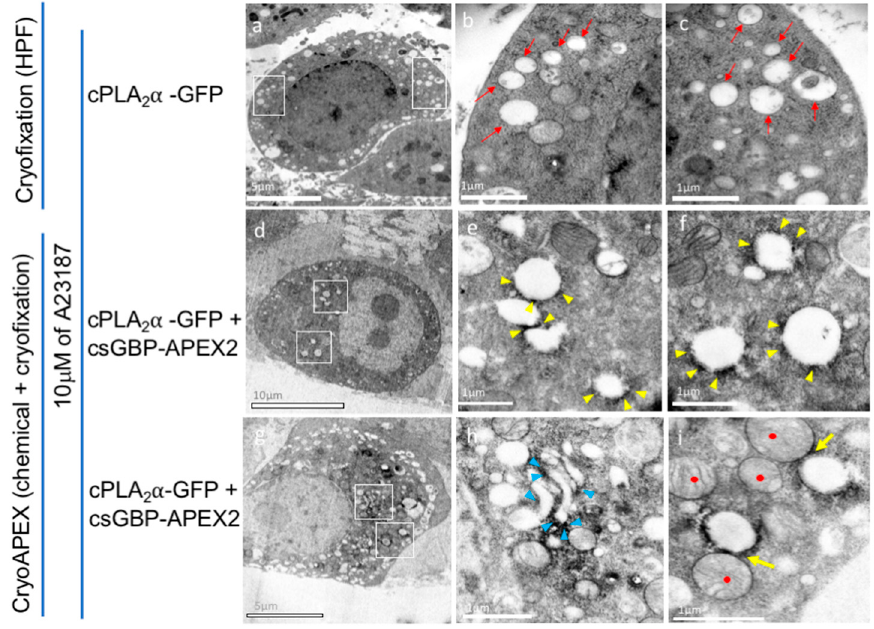
Figure 6. Cells ectopically expressing cPLA 2 α in the presence of calcium ionophore exhibit extensive vesicular structures with detectable presence of cPLA 2 α on vesicles and Golgi. ( a ) Cryogenically fixed (HPF) HeLa cells expressing cPLA 2 α when exposed to 10 μ M A23187 results in the accumulation of vesicular structures in the cytoplasm. At higher magnification of the areas ( a , white boxes) these vesicles show lack of density within and exhibit size heterogeneity (red arrows, b and c ). ( d ) Indirect cryoAPEX using an anti-GFP nanobody (APEX2-csGBP) tagged with APEX2 protein detected density corresponding to cPLA 2 α -GFP in the cytoplasm at lower magnification. ( e ) At higher magnifications the APEX2 specific osmium staining was apparent around these vesicles ( e and f , yellow arrowheads) indicating the concentration of cPLA 2 α in consonance with confocal imaging presented earlier. Stacked membrane bound structure resembling that of Golgi complex were also stained with apex2 specific osmium, ( g and h , blue arrowhead). These stained vesicles were often found to be closely associated with mitochondria (i, yellow arrow; red dots = mitochondria). Figure 7. Ectopic cPLA 2 α and/or C2 domain expression in the presence of A23187 induces vacuolization, fragmentation, and dispersion of the Golgi apparatus. ( a – c ) A HeLa stable cell line